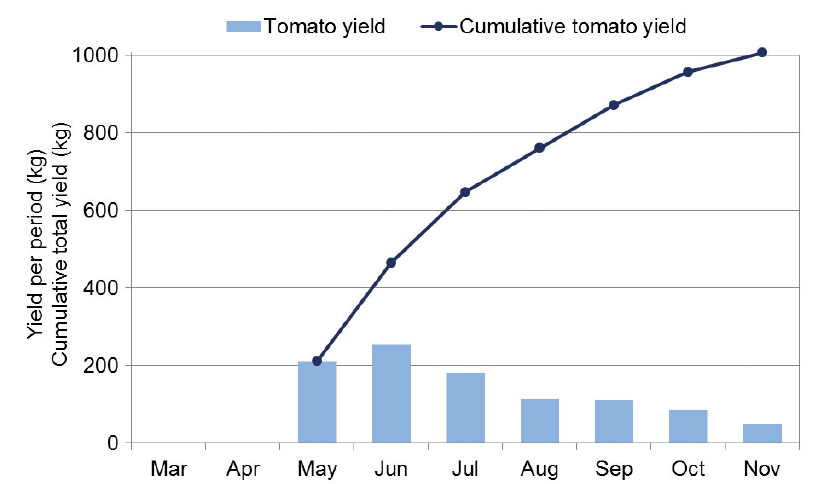
Fig. 5. Tomato Solanum lycopersicum production over the whole testing period. The tomato plants grew normally, and harvesting from a total of 113 plants started in May